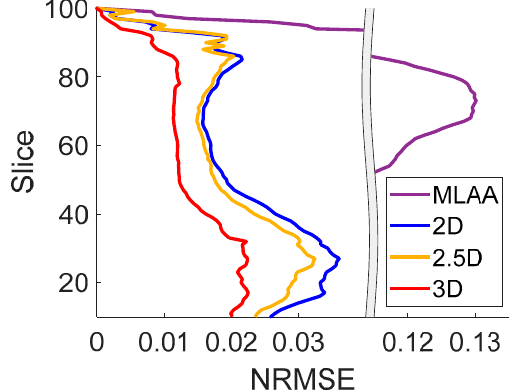
Figure 4. Normalized root mean square errors (NRMSE) relative to the CT-derived μ -map ( μ -CT) plotted along the axial slice location in a representative patient, as shown in Figures 2 and 3. The NRMSE between the U-net outputs ( μ -CNNs) and μ -CT is larger in the facial bone areas (smaller- numbered slices) such as the nasal cavity than in the cranial regions (larger-numbered slices).